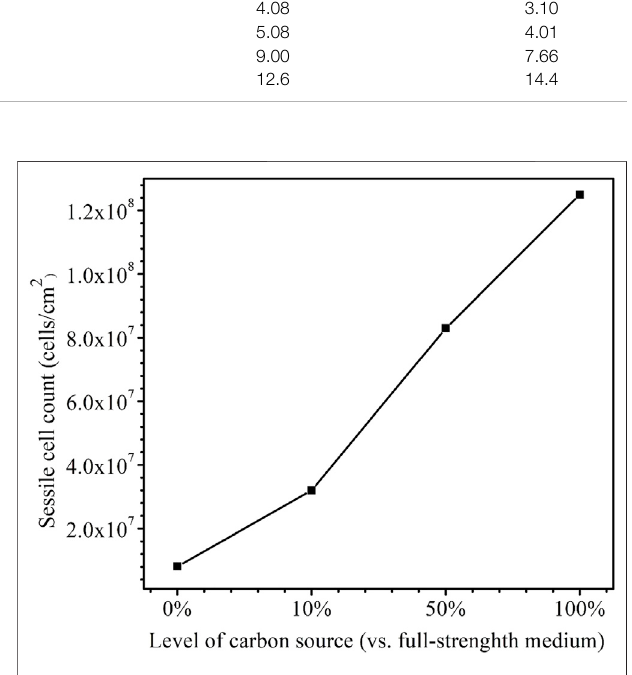
FIGURE 11 | Sessile cell counts on dogbone coupons after 14-days starvation incubation in 450-ml anaerobic bottles with varied carbon source